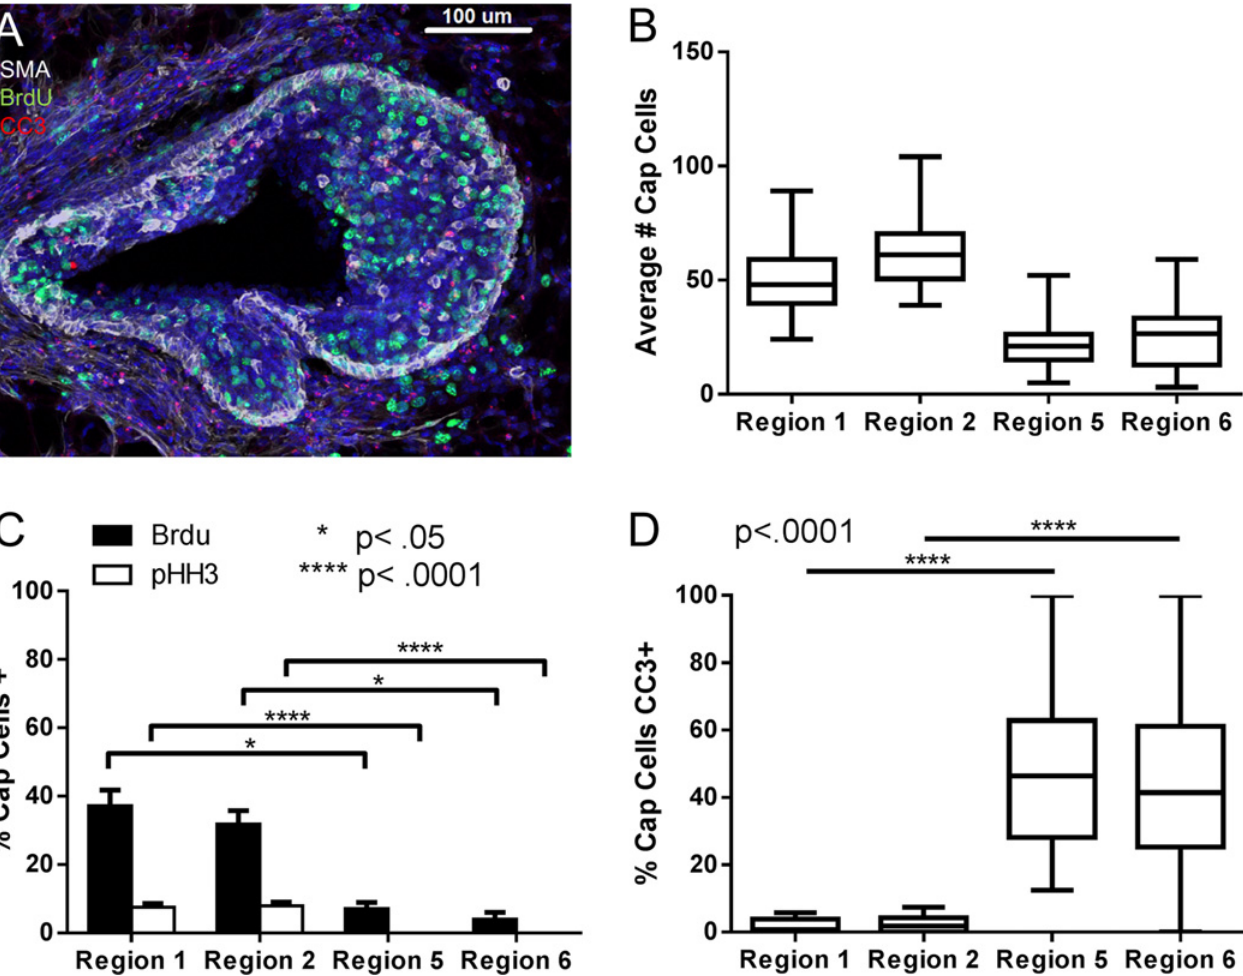
Fig 4. Cap cells migrate into body cell layer and undergo apoptosis. Proliferation status and apoptotic status of SMA+ cells were investigated in both the outer regions (Region 1 and 2) and the inner regions (Regions 5 and 6) of the TEB. A) Representative image of a TEB triple stained for SMA, BrdU, and CC3. B) Mean number of SMA+ cells present in each region, (whiskers denote range) n = 34 TEBs. C) SMA+ cells also positive for BrdU or pHH3 in each region presented as mean ± SEM, * p < .05, **** p < .0001, n = 34 TEBs. D) Quantification of SMA+ cells positive for CC3 in each region presented as mean, **** p < 0.0001 (whiskers denote range) n = 34